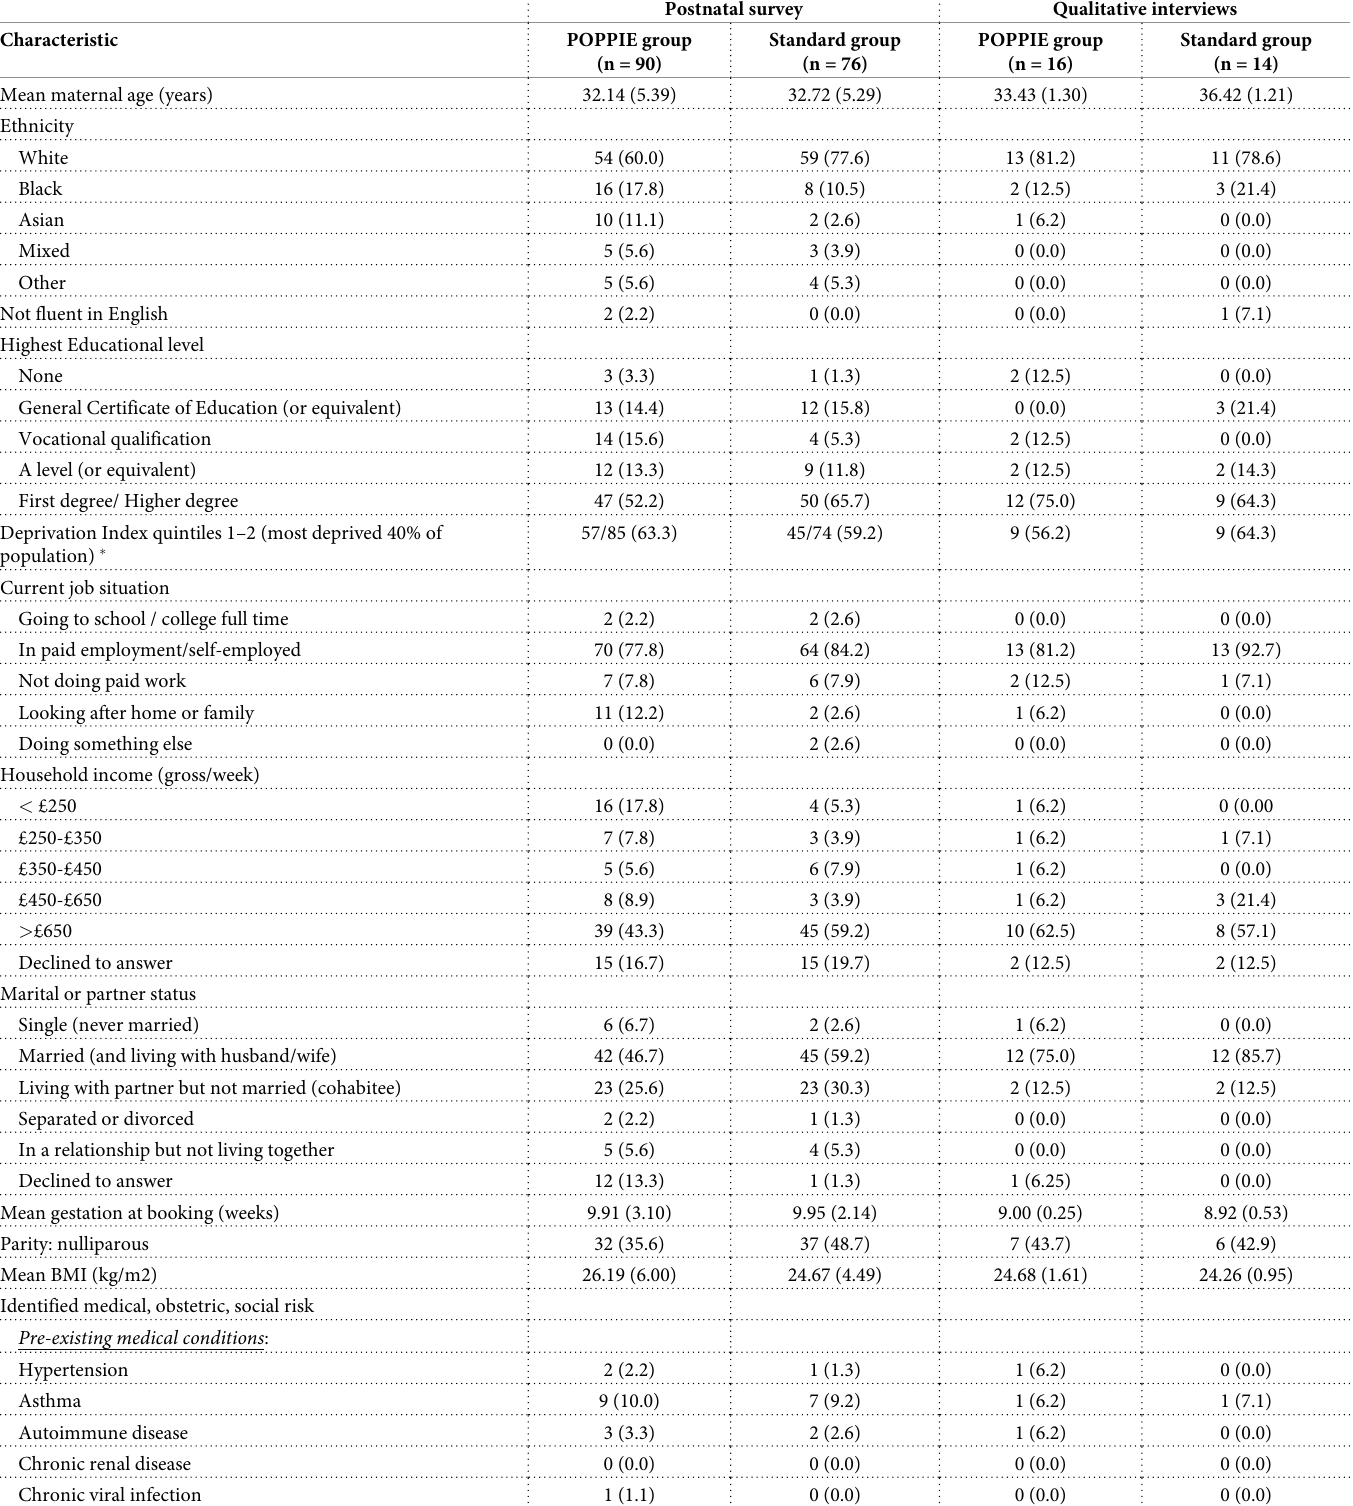
Table 1. Maternal characteristics at baseline.